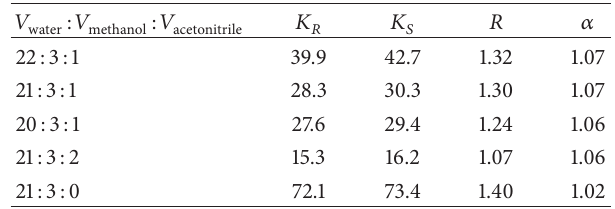
Table 2: Effect of the composition of mobile phase.